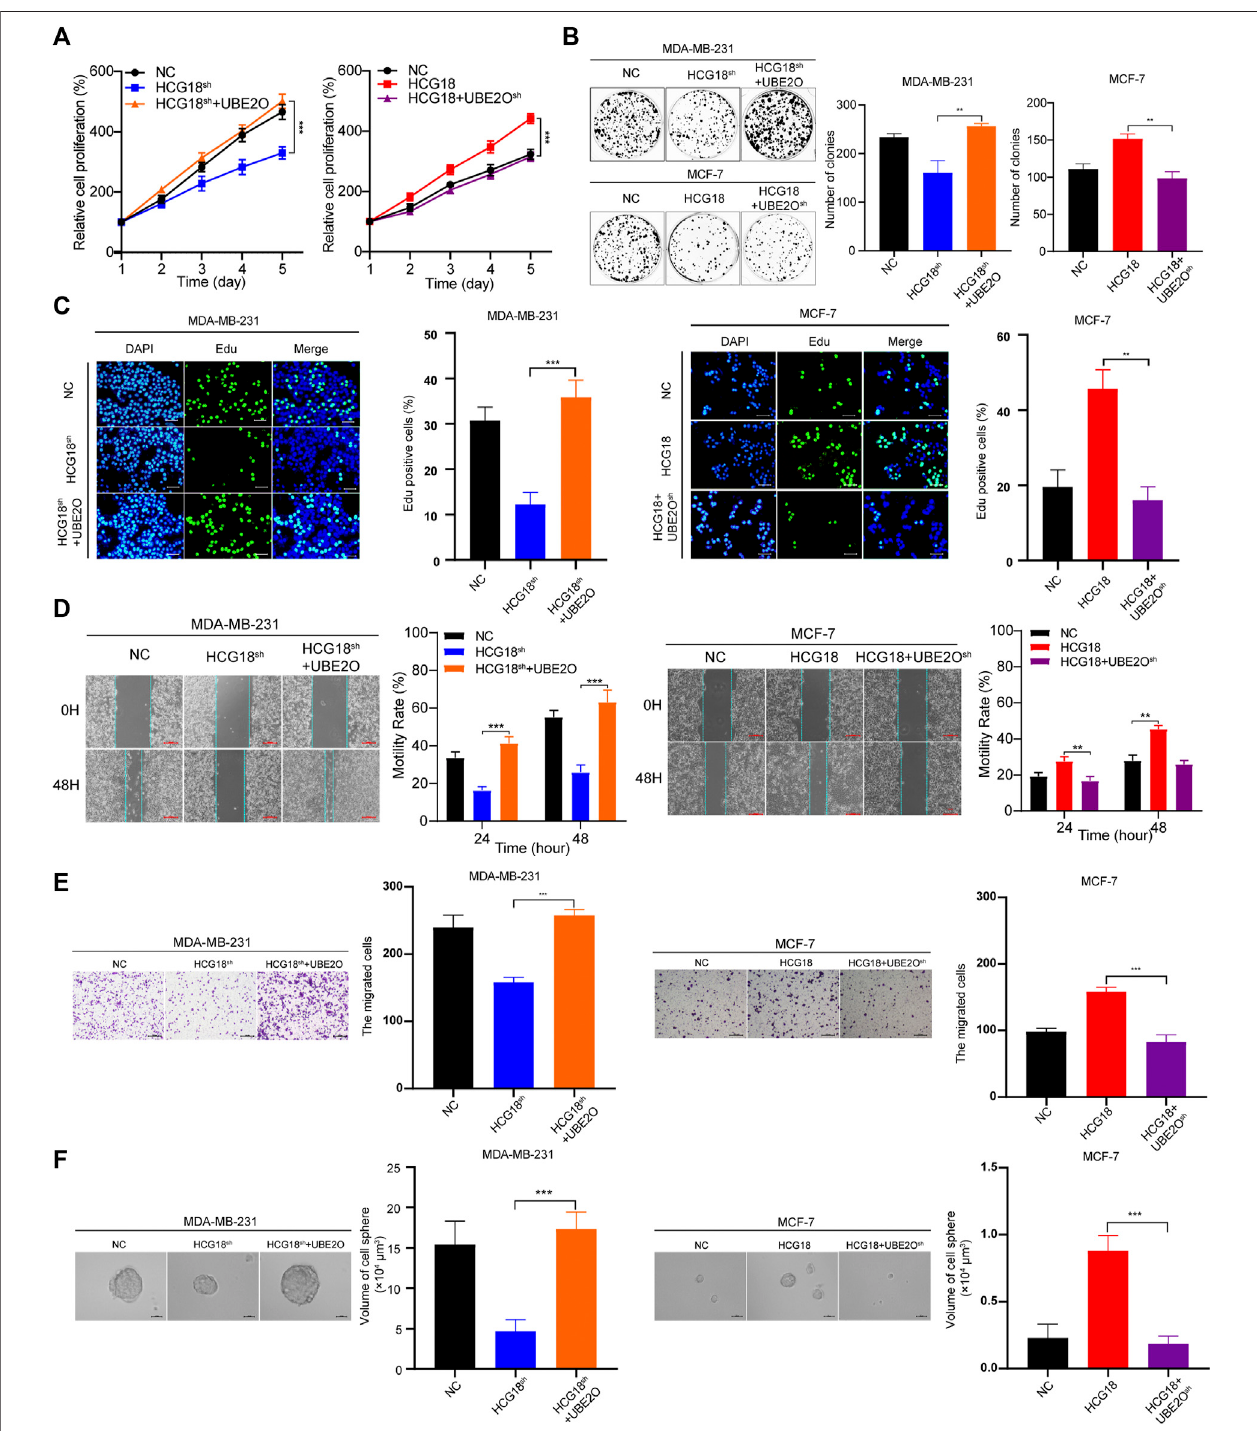
FIGURE 5 | (A – C) CCK-8 (A) , colony formation (B) and EdU staining assays (scale bar, 50 μ m) (C) were performed to detect the proliferation capabilities of MDA- MB-231 NC /MDA-MB-231 HCG18-sh /MDA-MB-231 HCG18-sh+UBE2O andMCF-7 NC /MCF-7 HCG18 /MCF-7 HCG18+UBE2O − sh cells. (D – F) UBE2OwaschangedinMDA-MB-231 and MCF-7 cells, and scratch assays (scale bar, 200 μ m) (D) , invasion assays (scale bar, 200 μ m) (E) , and sphere formation assays (scale bar, 20 μ m) (F) were performed to detect the migration, invasion, and sphere formation capabilities in the indicated cells. The data are shown as the mean ± SD. * p < 0.05, ** p < 0.01, *** p < 0.001. The data represent at least three independent experiments.